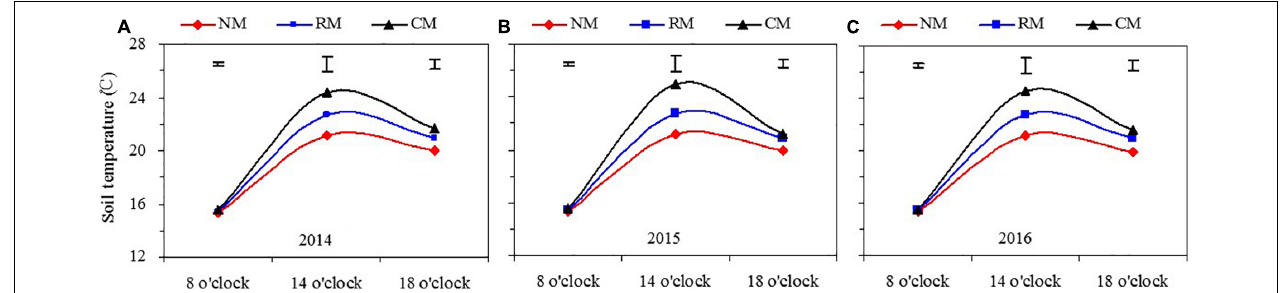
FIGURE 3 | Dynamics of daily soil temperature in the 5–25 cm soil layer in maize field as affected by plastic mulching practices across the entire growing season in 2014 (A) , 2015 (B) , and 2016 (C) . NM, no tillage with plastic re-mulching; RM, no tillage with plastic mulching after maize was harvested in autumn and new plastic was mulched in next spring after the old plastic was removed off the field and rotary ploughed; CM, conventional deep tillage (the depth is 30 cm) after maize was harvested and the old plastic was removed off the field in autumn, and new plastic was mulched in next spring before maize sowing. The length of vertical bars represents the magnitude of the least significant difference (LSD) at P = 0.05 among treatments within a measurement time. NS, no significant difference at the 0.05 probability levels.